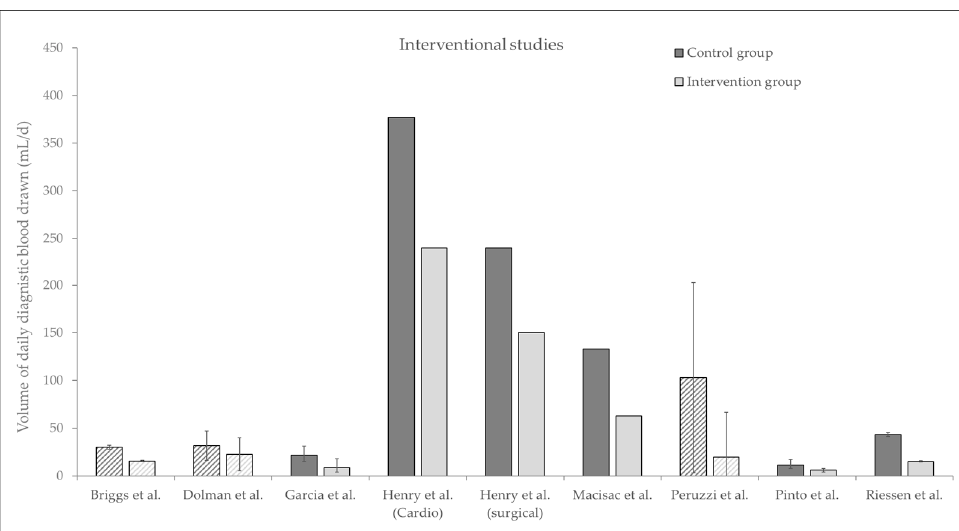
Figure 2. Interventional studies. Daily diagnostic blood drawn in mL/d, before and after intervention. Plain bars show median with interquartile range, and crosshatched bars show mean values with standard deviation.